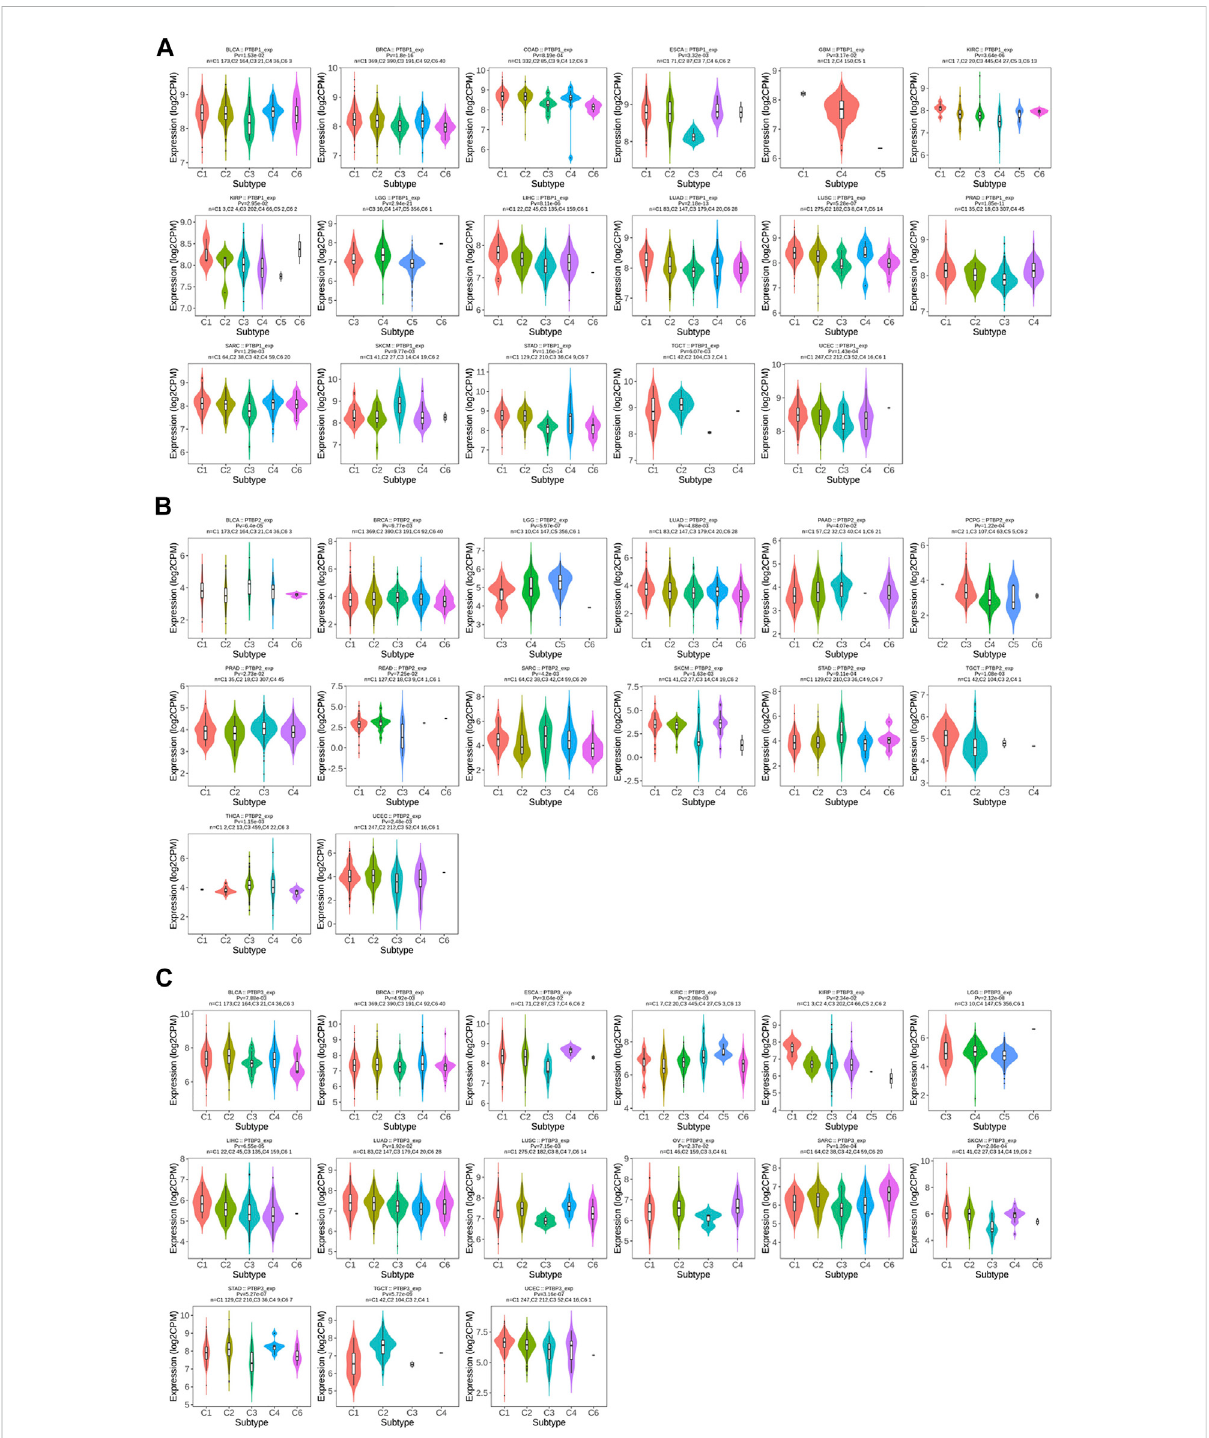
FIGURE 5 The relationship between PTBP expression and tumor immune subtype. (A) Expression levels of PTBP1 in immune subtypes. (B) Expression levels of PTBP2 in immune subtypes. (C) Expression levels of PTBP3 in immune subtypes. These results are statistically signi fi